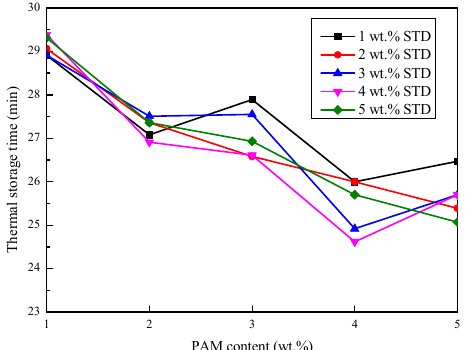
Figure 5. Effect of PAM and STD content on the thermal storage time of the Na 2 SO 4 · 10H 2 O–5 wt.% KCl eutectics.